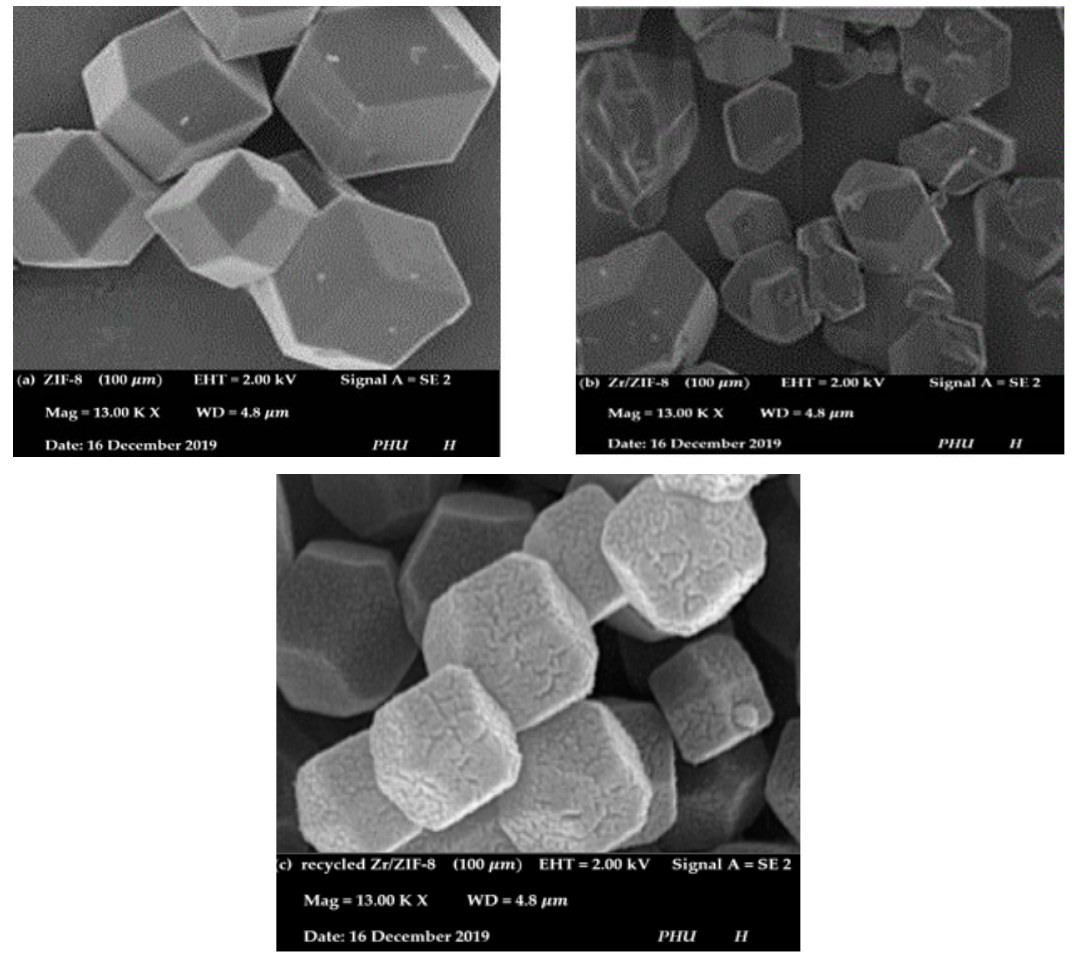
Figure 6. Scanning Electron Microscope (SEM) images of ( a ) ZIF-8 crystals, ( b ) Zr / ZIF-8, and ( c ) recycled Zr / ZIF-8 crystals synthesized with 10% dopant of Zr.